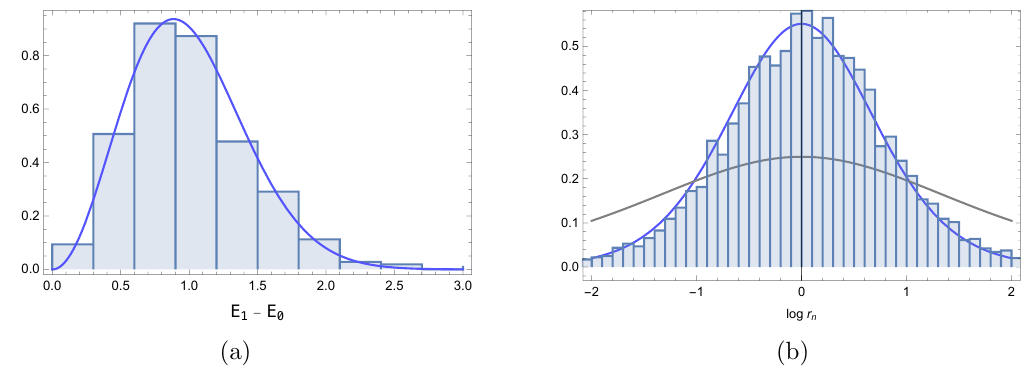
Figure 3. Level spacing statistics for the edge of the SYK spectrum, with N = 46 Majorana fermions and 355 realizations. (a) The spacing distribution for the two lowest levels, compared with the RMT prediction for the corresponding GUE ensemble. (b) The distribution of log( r n ) (described in the text) computed over the lowest 20 energy levels, compared with the RMT prediction (blue) and with the prediction for uncorrelated energies (gray).